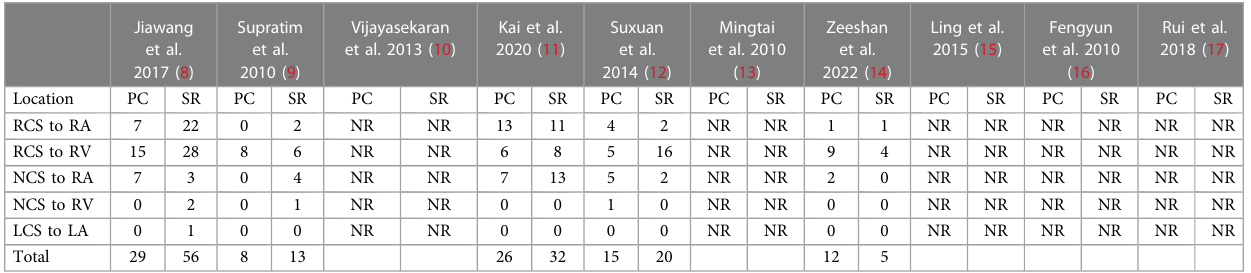
TABLE 3 RSVA locations in the